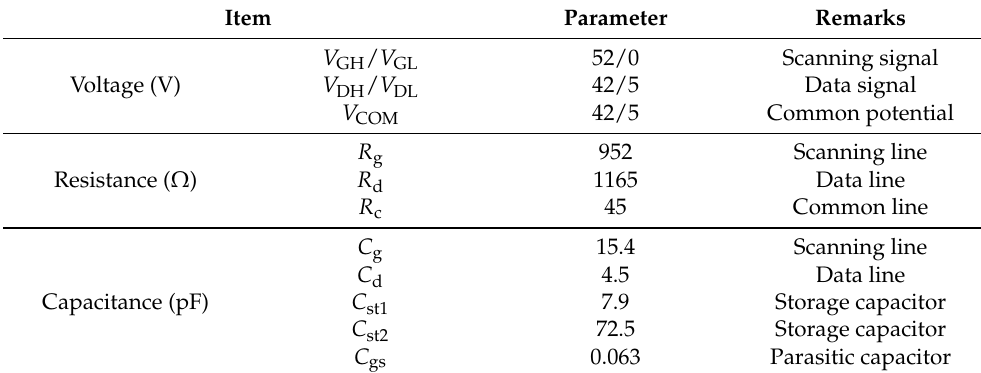
Table 2. Key circuit parameters used for simulation of the 1T1C pixel.